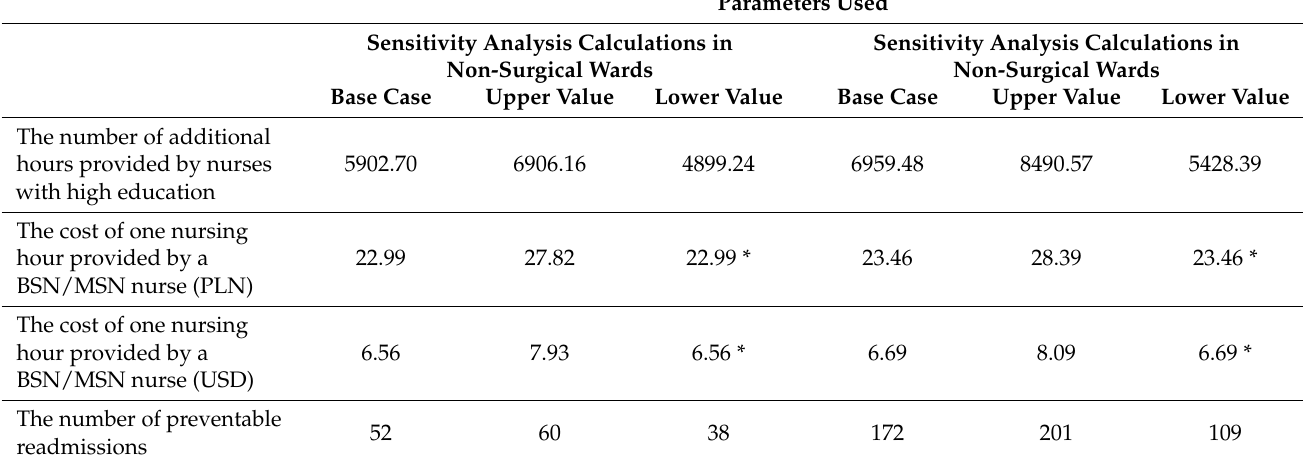
Table 4. The parameters and calculations used in the sensitivity